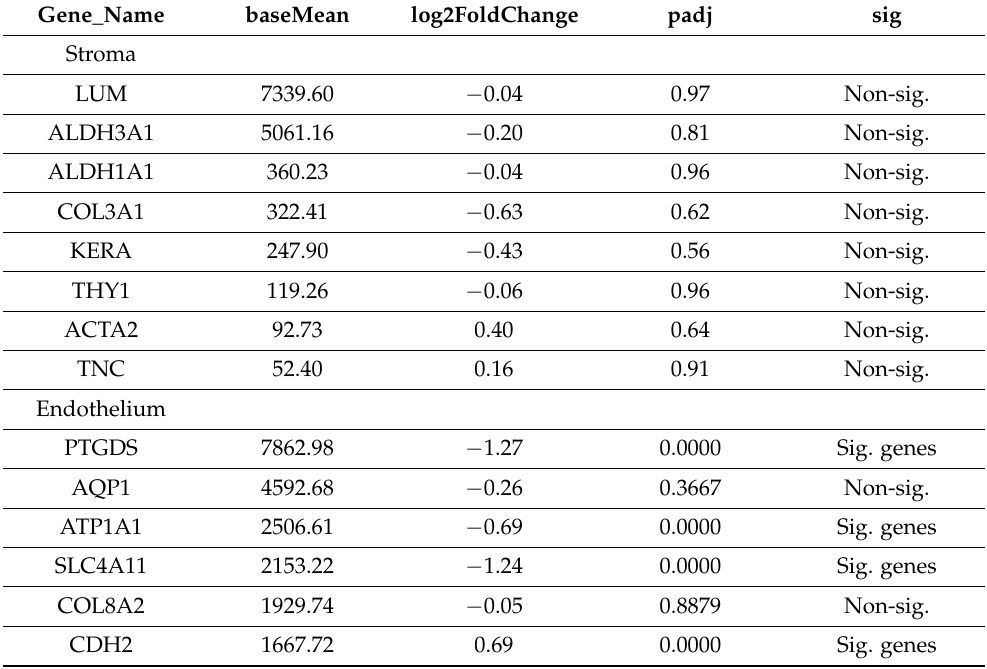
Table 5. Expression levels of known marker genes for stromal and corneal endothelial cells following differential organ culture in either 2%HPL or 2%FBS for 25